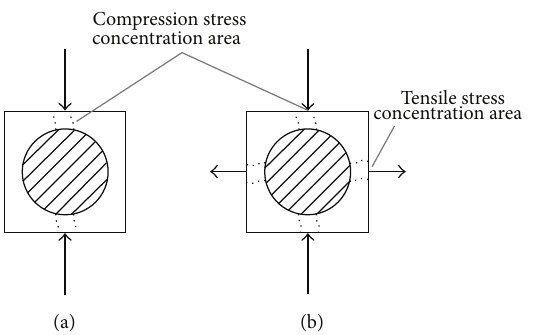
Figure 6: Stress concentration areas in uniaxial compression and “pure shear” load cases.